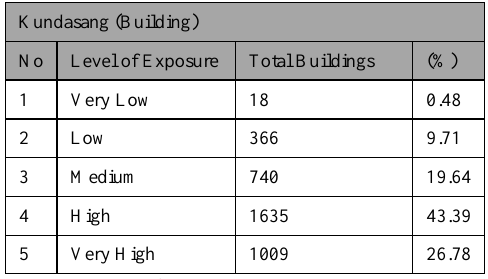
Table 3: Level of building exposure toward hazard in Kundasang